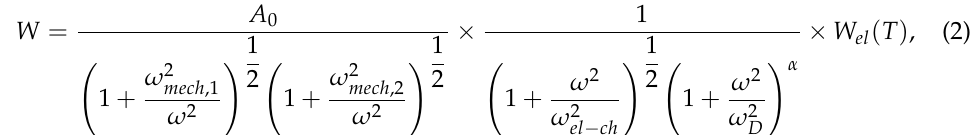
where W mech , W el − ch are the transfer functions of the mechanical and electrochemical systems, respectively, and W el is the transfer function of the associated electronics. If the first two components have physical principles of dependence on temperature, then, in the circuit of the accompanying electronics there is a circuit, that compensates for this dependence. It was demonstrated in [21] that the transfer function of the sensor can be